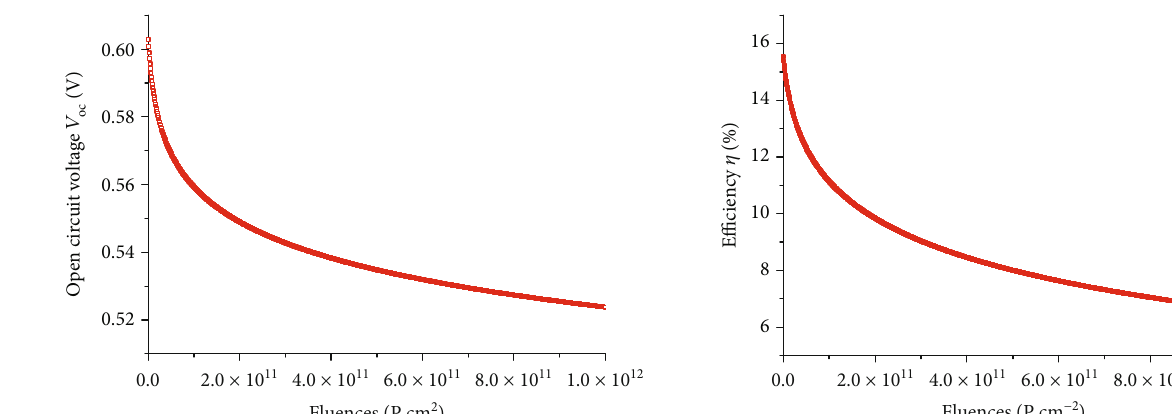
= 0 : 02 cm ; Sb = 0 = 27 cm 2 : s − 1 ; H = 0 : 03 cm ; Kl = n